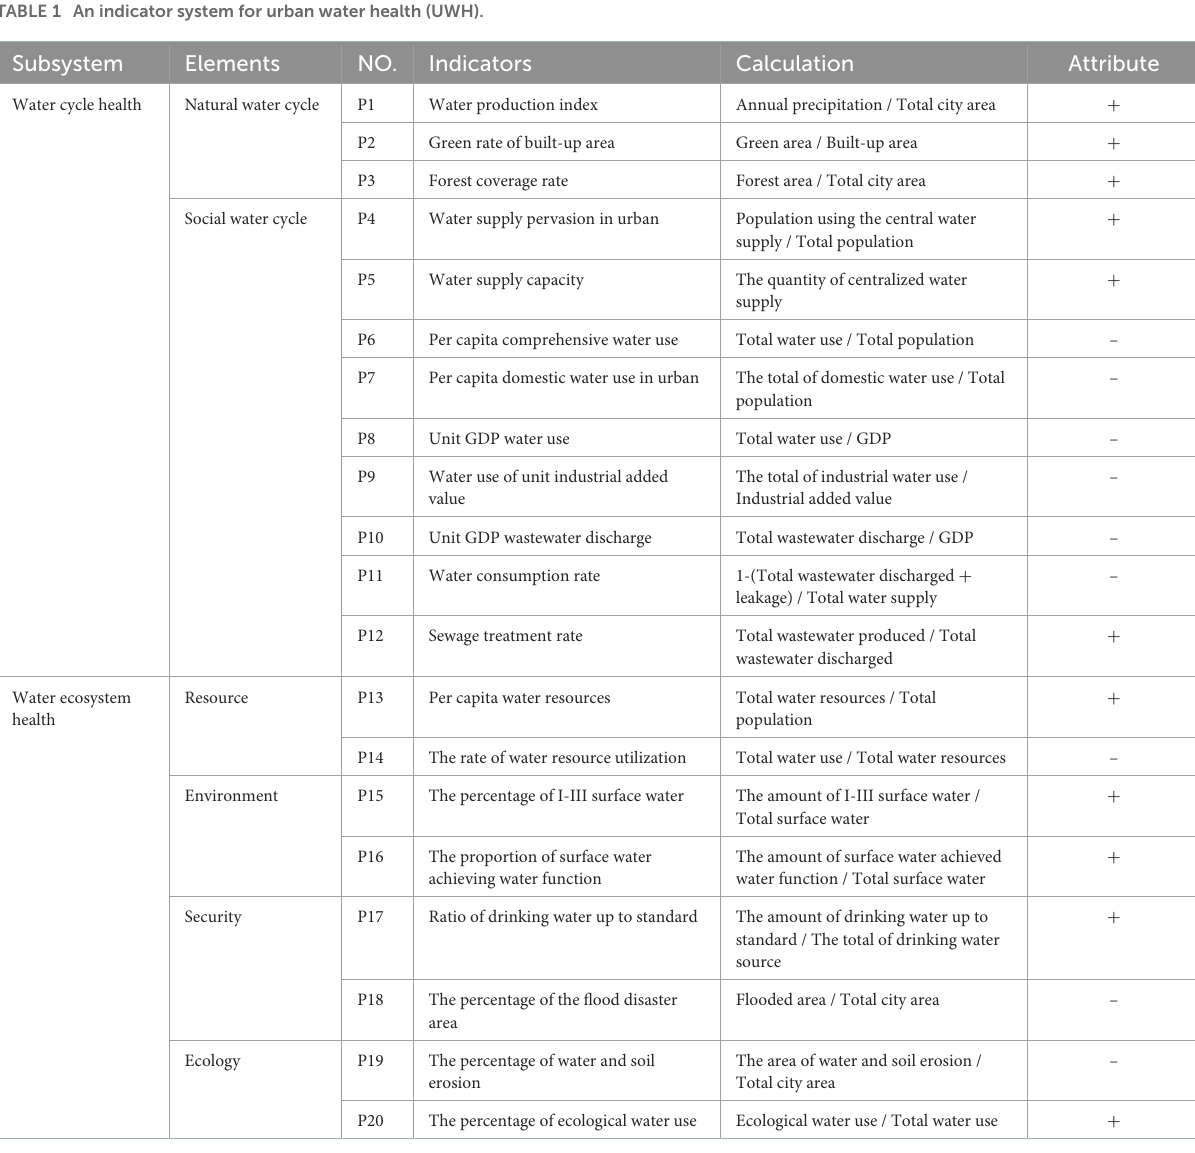
TABLE 1 An indicator system for urban water health